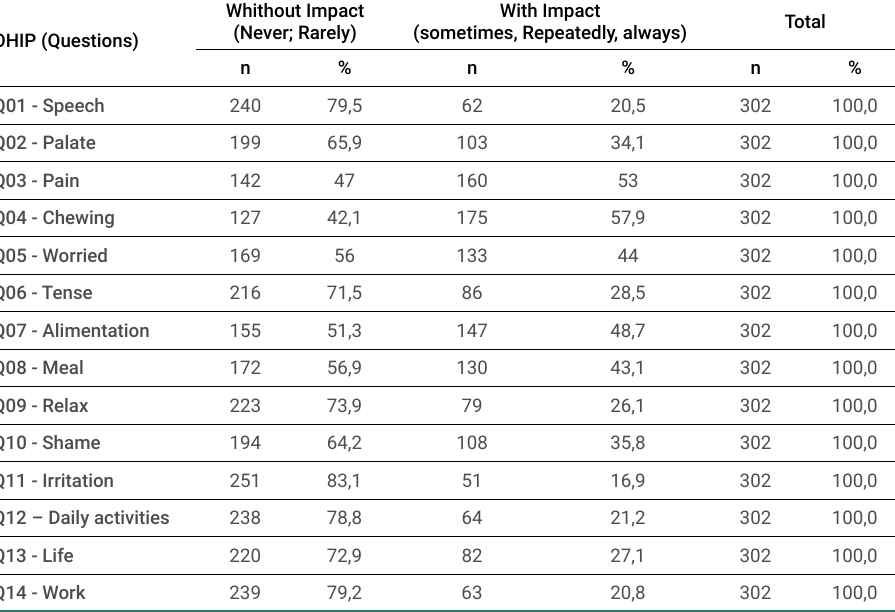
Table 3. Prevalence of impact of oral alterations on OHIP-14 quality of life among subjects with DM2